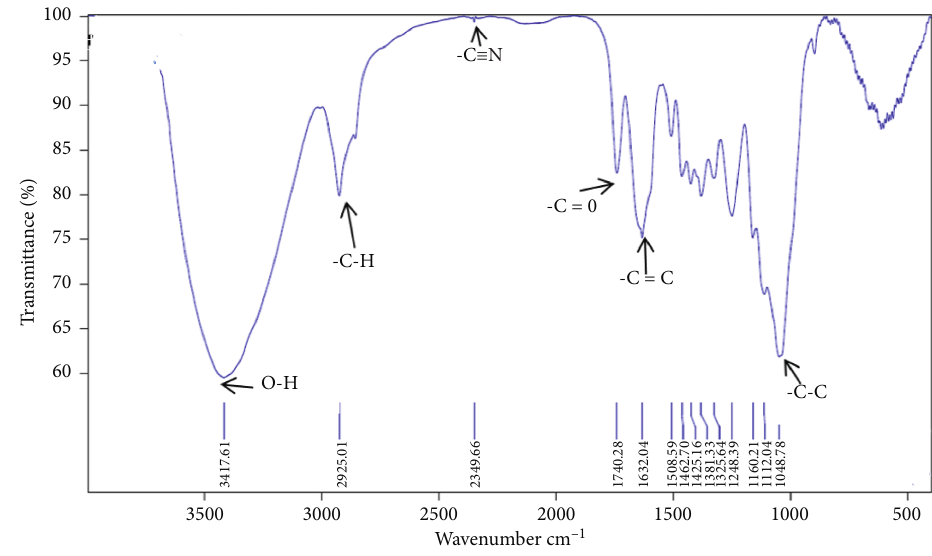
Figure 2: FTIR spectrum of the analyzed almond shell powder (ASP). Table 2: Textural characteristic of almond shell powder (ASP). ASP/BET surface area (m 2 /g) 0.19 Pores diameter BJH (˚A)